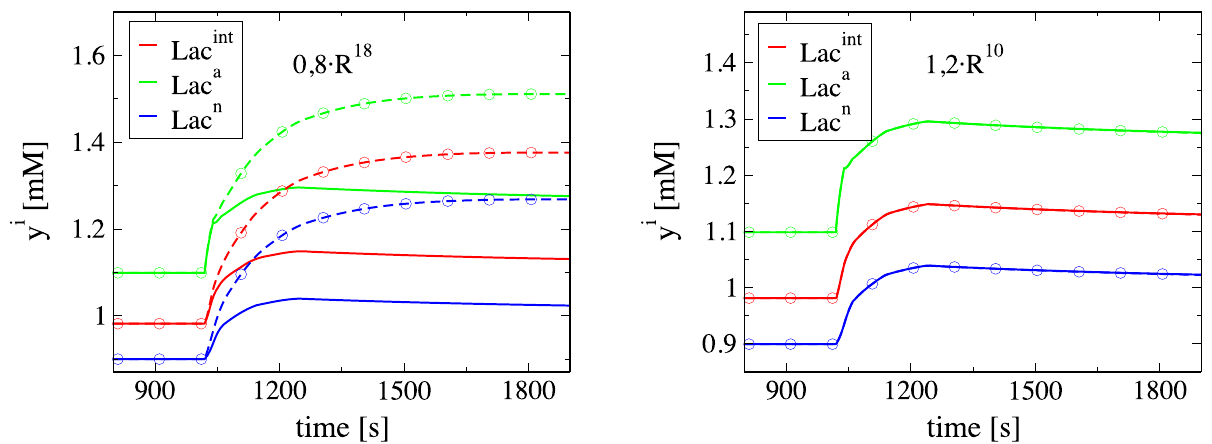
Fig 5. Response of Lac int , a , n in decrease/increase of R 18 / R 10 . Evolution of Lac int , a , n during neuronal activation. Comparison of the solution under normal conditions (solid lines) with the one under perturbed rates conditions (dashed lines with circles). Left: Decrease of R 18 by 20%. Right: Increase of R 10 by 20%.